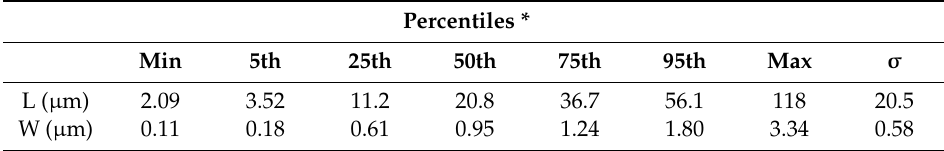
Figure 2. Selected examples of SEM microphotographs of the mordenite samples: ( a , b ) general overview of the sample; ( c , d ) close-up of very elongated and narrow mordenite crystals. Table 1. Summary statistic of mordenite fibers geometry. L (length); W (width); Min (minimum); Max (maximum); σ (standard deviation). * Percentile is a value below which a given percentage of values in a dataset fall. Example: given a group of observations, the 25th percentile is the value that is greater or equal to 25% of the observations, i.e., the 25% of fibers have L ≤ 11.2 µm and W ≤ 0.61 µm.